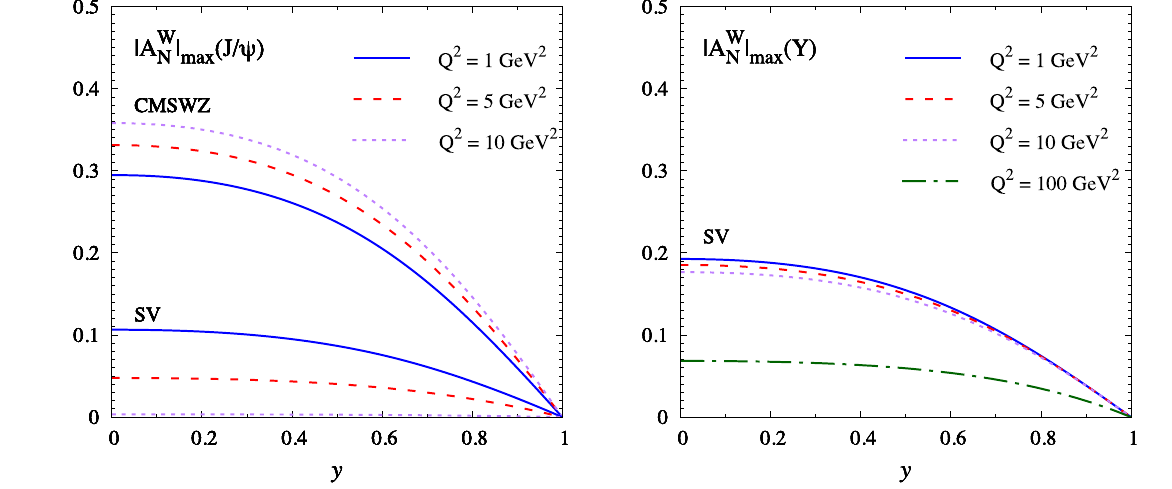
Fig. 3 Upper bounds for the (cid:2) cos2 φ T (cid:3) and A W asymmetries, with sets, given in Tables 1 and 2. The bounds obtained with the BCKL set, N W = sin (φ S + φ T ), sin (φ S − 3 φ T ) , for e p → e (cid:5) J /ψ X (leftpanel)and not shown explicitly, lie always between the SV and CMSWZ results e p → e (cid:5) ϒ X (right panel), as a function of y and for different values presented in the left panel of the scale Q 2 . The labels SV and CMSWZ denote the adopted LDME